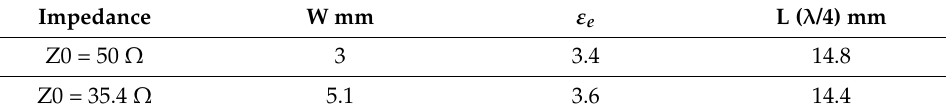
Figure 5. The branch line coupler reflection coefficient, S11.